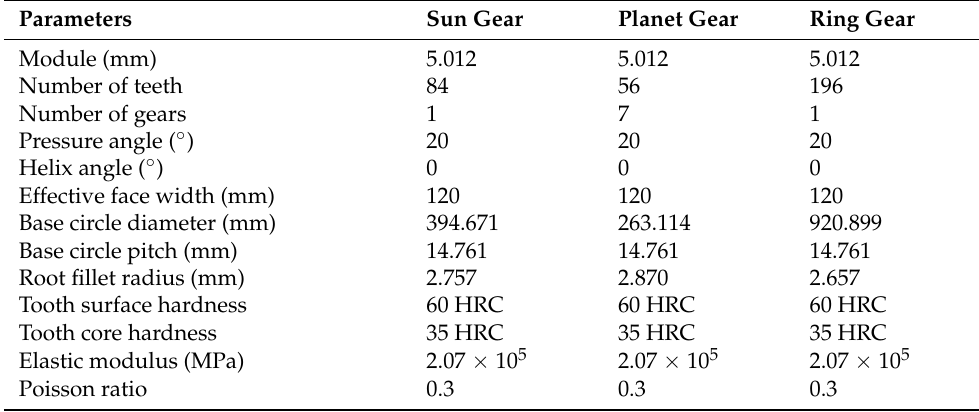
Figure 1. System model of planetary mechanism. Table 1. Geometric parameter of planetary gear train.